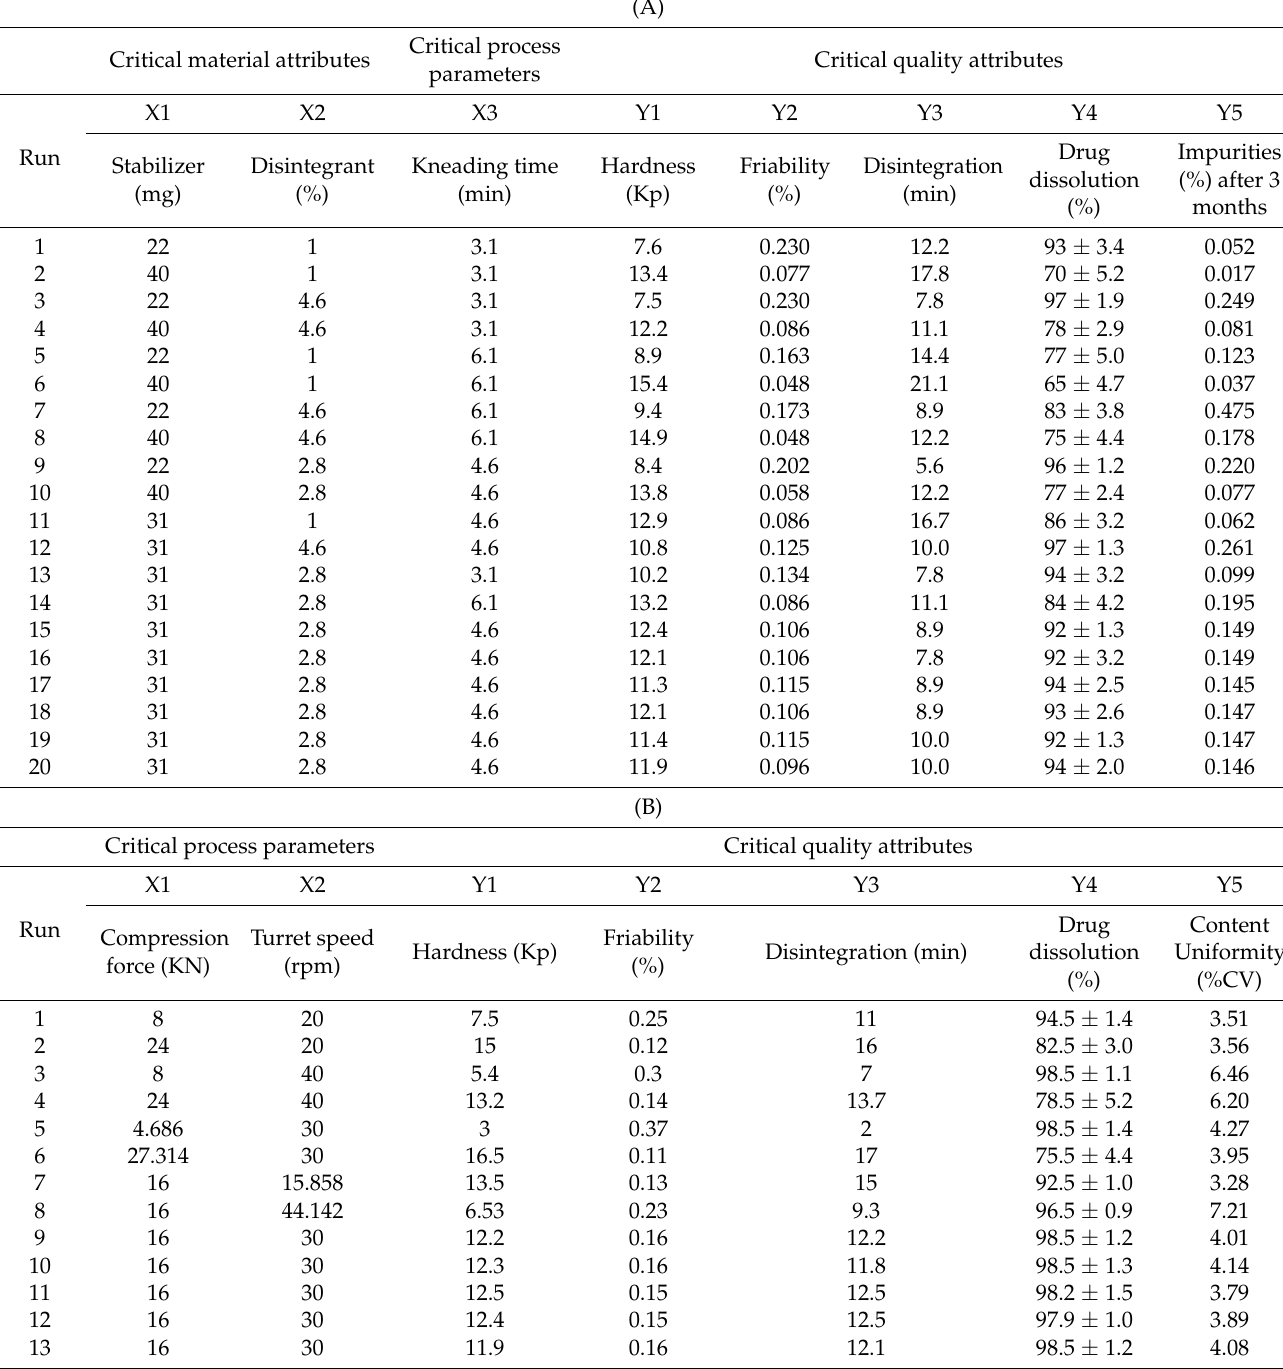
Table 3. Experimental matrix and measured responses values for optimization of the TA tablet using face centered central composite design for wet granulation (A), and central composite design for tablet compression (B).